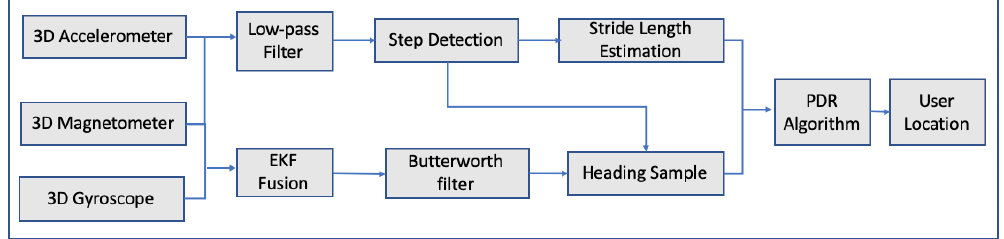
Figure 8. System architecture in Reference